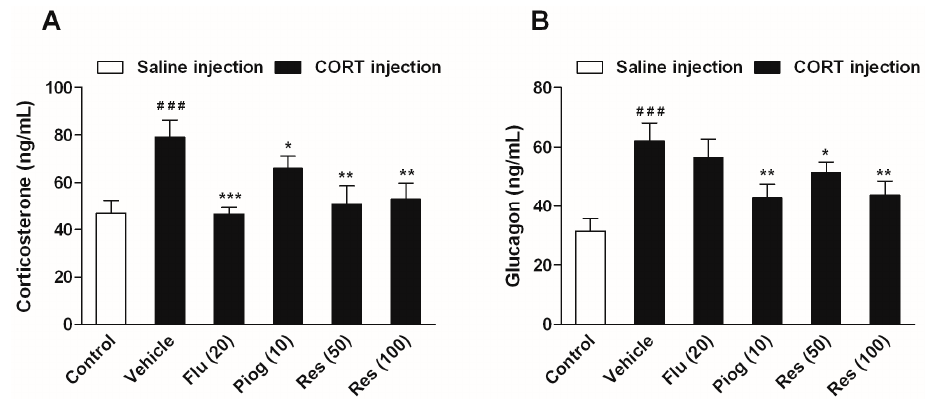
Figure 6. Effects of resveratrol on the serum hormone levels in CORT- treated mice. ( A ) Serum level of corticosterone; ( B ) Serum level of glucagon. Data were expressed as the mean ± S.E.M. ( n = 10). ### p < 0.001 vs. control group. * p < 0.05, ** p < 0.01 and *** p < 0.001 vs. CORT-vehicle group. Data was analyzed by one-way ANOVA followed by Dunnett ′ s post hoc test.